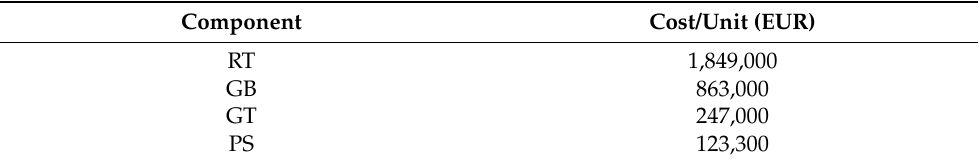
Table 8. Overall cost of the turbine’s